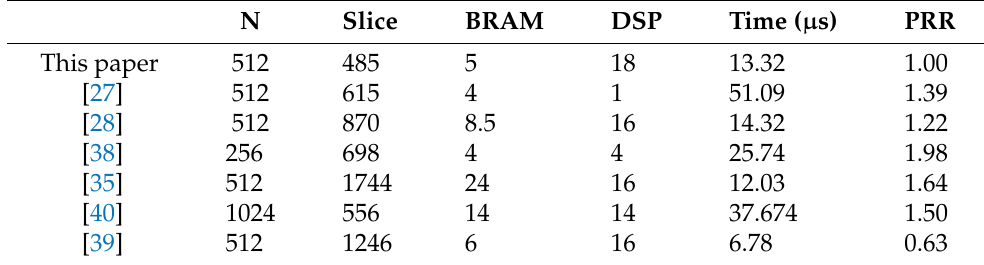
Table 5. PRR comparison of polynomial multiplier’s FPGA